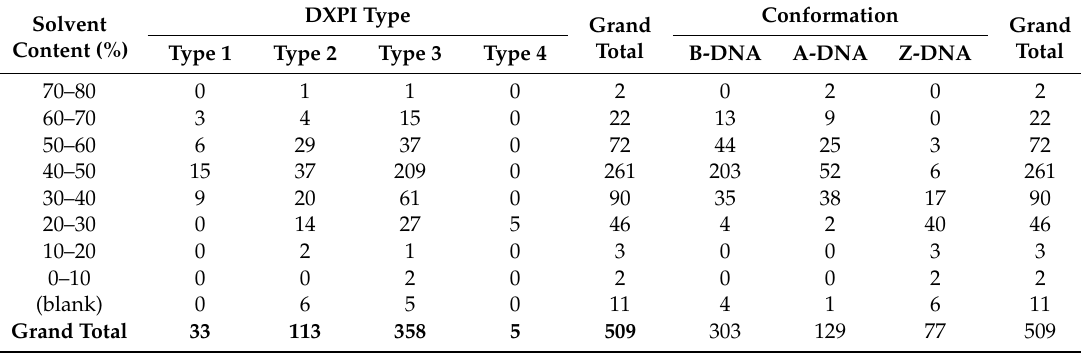
Table 7. Number of DNA structures containing di ff erent percentage range of solvent content, their packing types, and conformations. Full list is provided in Table